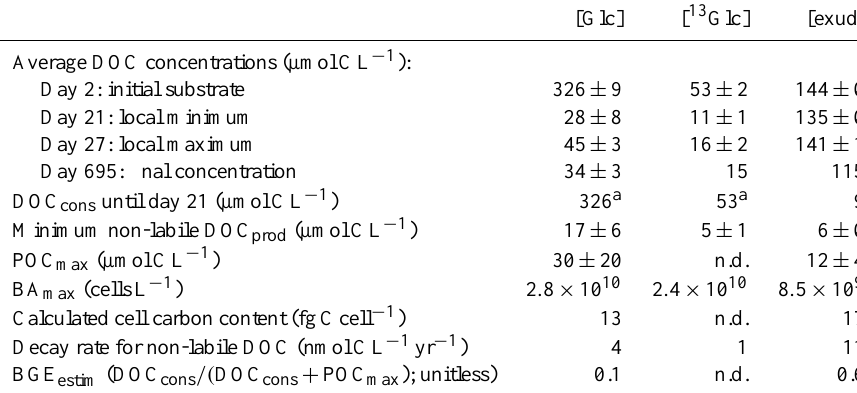
Table 2. DOC concentrations for selected days, DOC consumed (DOC cons ), minimum of non-labile DOC produced (calculated from the DOC concentration at day 27 minus day 21; DOC prod ), maximum POC concentration (POC max ), maximum abundance of bacterial cells (BA max ), cell carbon content ( = POC max / BA max ), decay rate of non-labile DOC (period from day 27 until day 695) and the estimated bacterial growth efficiency (BGE estim ). Note – n.d. stands for not determined. [Glc]